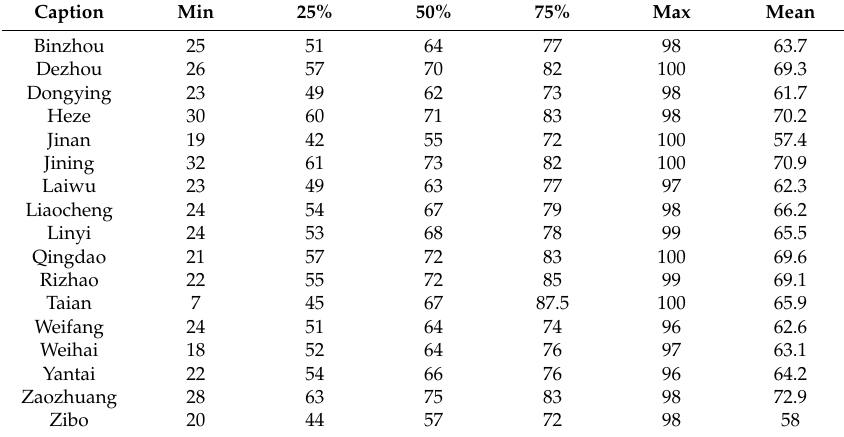
Table A6. Descriptive statistics of the daily mean relative humidity (%) in the 17 cities of the Shandong province (from 1 January 2015 to 31 December